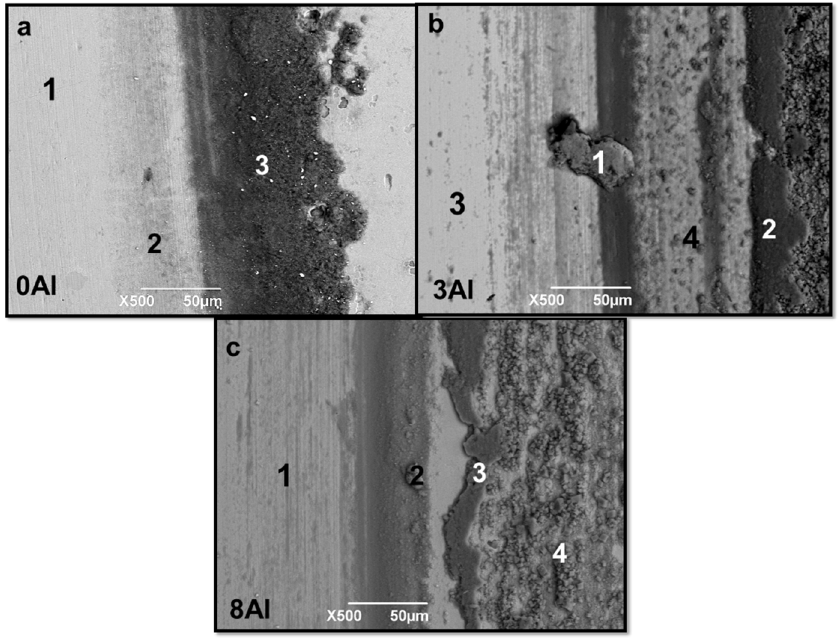
Figure 7. SEM images of the ( a ) 0Al; ( b ) 3Al; ( c ) 8Al alloys under pure sliding wear, W 0 . The numbers correspond to the spectrum showed in Table 6. Table 6. EDS composition (wt.%) corresponding to the surfaces of the alloys shown in Figure 7.